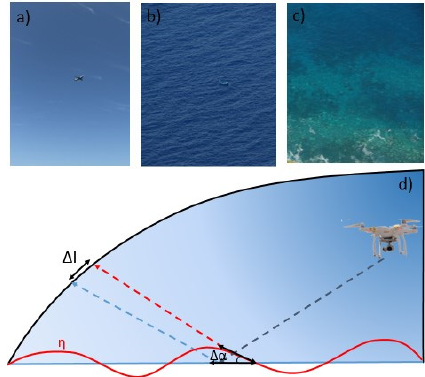
Figure 1. ( a ) Illustration of the sky half-dome coloring from dark at nadir to bright at the horizon along the view angle cross-section, ( b ) how the specular reflection on the ocean surface looks like and how wave appear, and ( c ) when looking down with avoiding specular reflection and favoring penetration. ( d ) Sketch of the method principle.